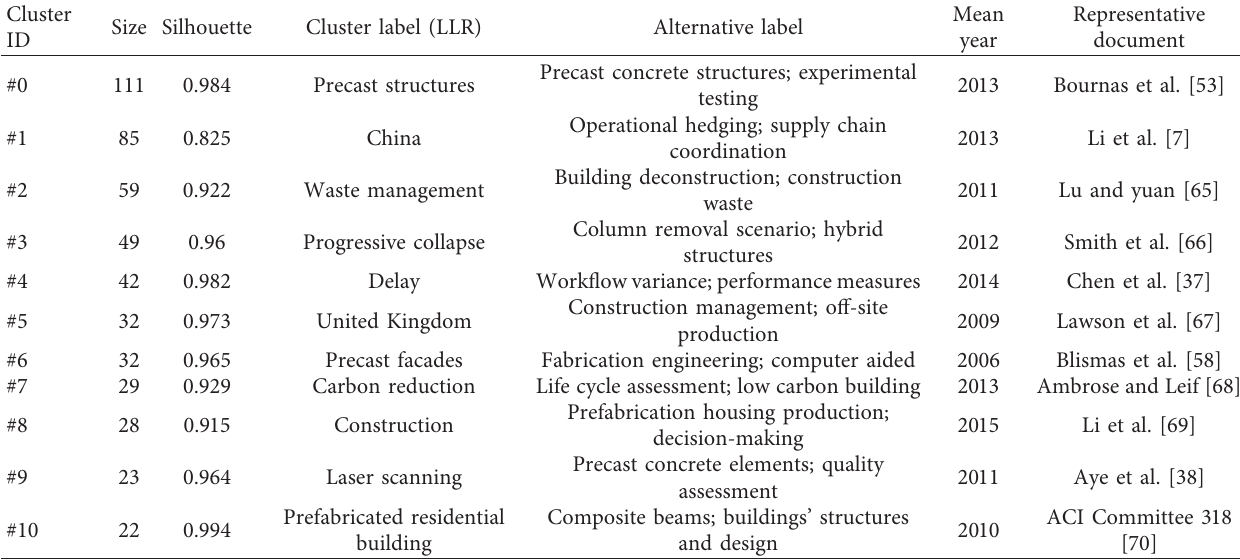
Table 11: Co-citation clusters of prefabricated building research in